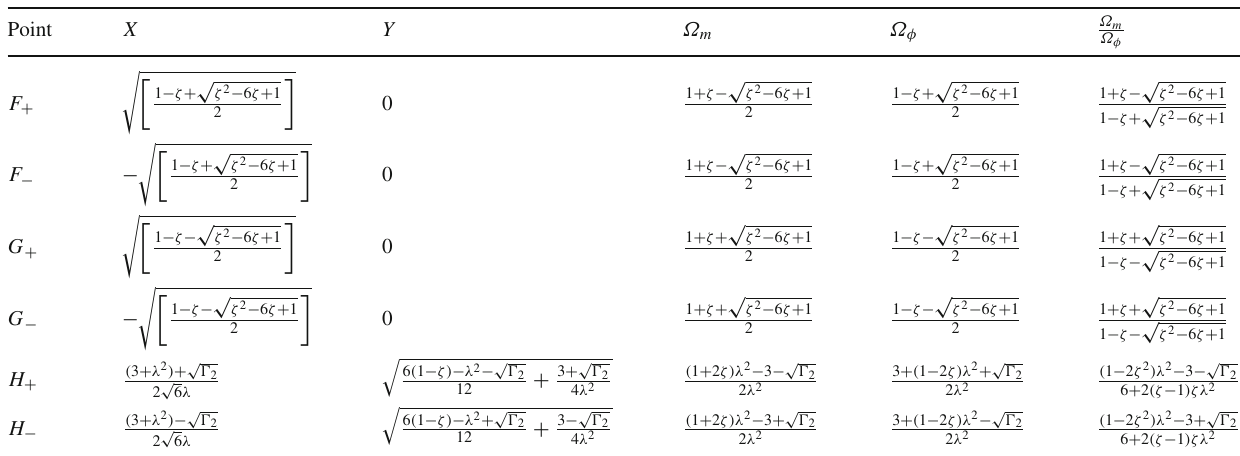
Table 5 The physically meaningful critical points of the autonomous system for the case α = β ≡ ζ Point Existence Stability q < 0 ω ef f √ √ F + 0 ≤ ζ < 3 − 2 2 Saddle for λ > 6 and ζ = 0 No √ Saddle for λ > w 1 (ζ) and 0 < ζ < 3 − 2 2 √ Unstable for λ < 6 and ζ = 0 √ Unstable for λ < w 1 (ζ) and 0 < ζ < 3 − 2 2 √ −√ F − 0 ≤ ζ < 3 − 2 2 Saddle for λ < 6 and ζ = 0 No √ Saddle for λ < − w 1 (ζ) and 0 < ζ < 3 − 2 2 −√ Unstable for λ > 6 and ζ = 0 √ Unstable for λ > − w 1 (ζ) and 0 < ζ < 3 − 2 2 Saddle for all λ and ζ = 0 √ Stable for λ > w 2 (ζ) and 0 < ζ < 3 − 2 2 Saddle for all λ and ζ = 0 √ Stable for λ < − w 2 (ζ) and 0 < ζ < 3 − 2 2 √ √ H + Region 3 Saddle 3 < λ < 6 and ζ = 0 No (in the Appendix) Saddle point in region i in Fig. 4 with ζ (cid:2)= 0 H − Region 4 Stable: part ii in Fig. 5 (in the Appendix) Unstable: part iii in Fig. 5 or Stable spiral: part iv in 5 Unstable spiral: part v in 5 Centre: Black curve in Fig.